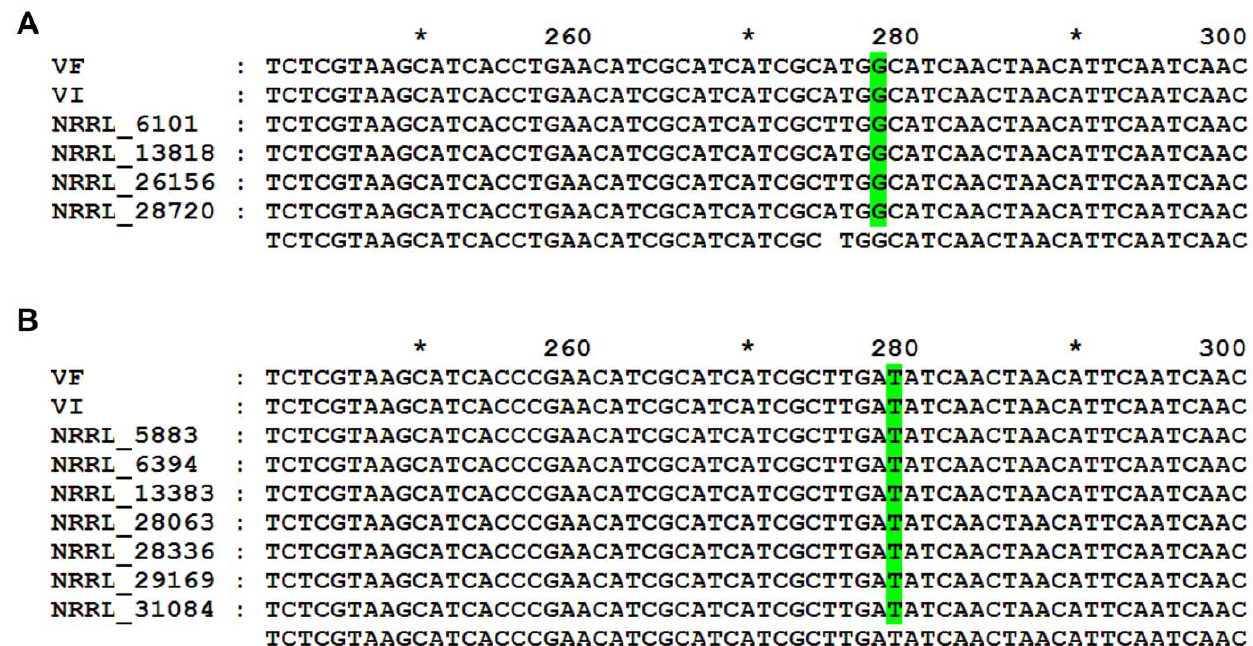
Figure 4. Alignments of histone H3 sequences from F.asiaticum (A) and F.graminearum (B) strains. VF=virus-free; VI=virus-infected. The fixed nucleotide characters are shaded in green. The presence of nucleotides G (position 278) and T (position 279) is differentially fixed for F. asiaticum and F. graminearum , respectively. GenBank accession numbers of nucleotide sequences used are as follows: NRRL 6101 (AY452820.1), NRRL 13818 (AY452821.1), NRRL 26156 (AY452843.1), NRRL 28720 (AY452844.1), NRRL 5883 (AY452815.1), NRRL 6394 (AY452817.1), NRRL 13383 (AY452819.1), NRRL 28063 (AY452816.1), NRRL 28336 (AY452818.1), NRRL 29169 (AY452836.1), NRRL 31084 (AY452852.1).